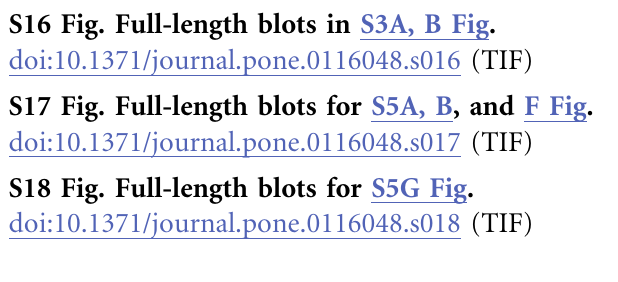
S16 Fig. Full-length blots in S3A, B Fig. doi:10.1371/journal.pone.0116048.s016 (TIF) S17 Fig. Full-length blots for S5A, B, and F Fig. doi:10.1371/journal.pone.0116048.s017 (TIF) S18 Fig. Full-length blots for S5G Fig.